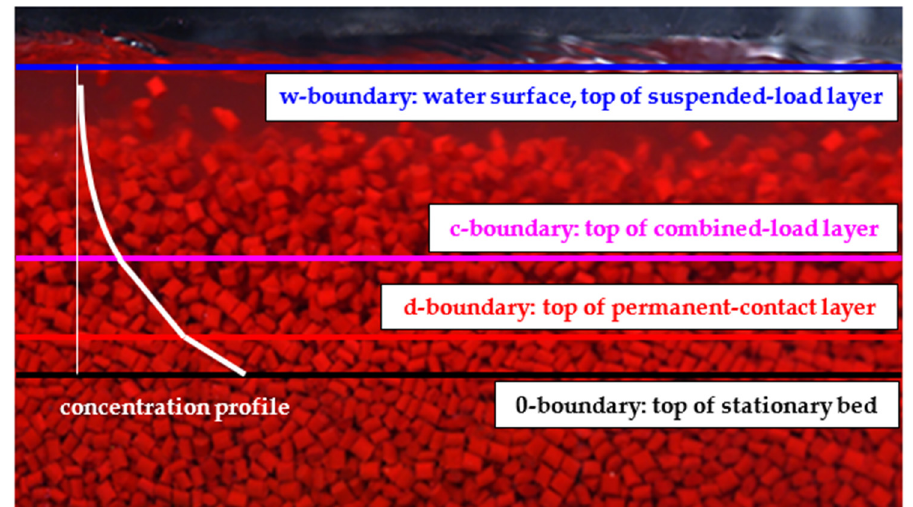
Figure 1. Layered structure of modelled flow including schematic concentration profile projected onto photograph of combined-load transport in tilting flume.